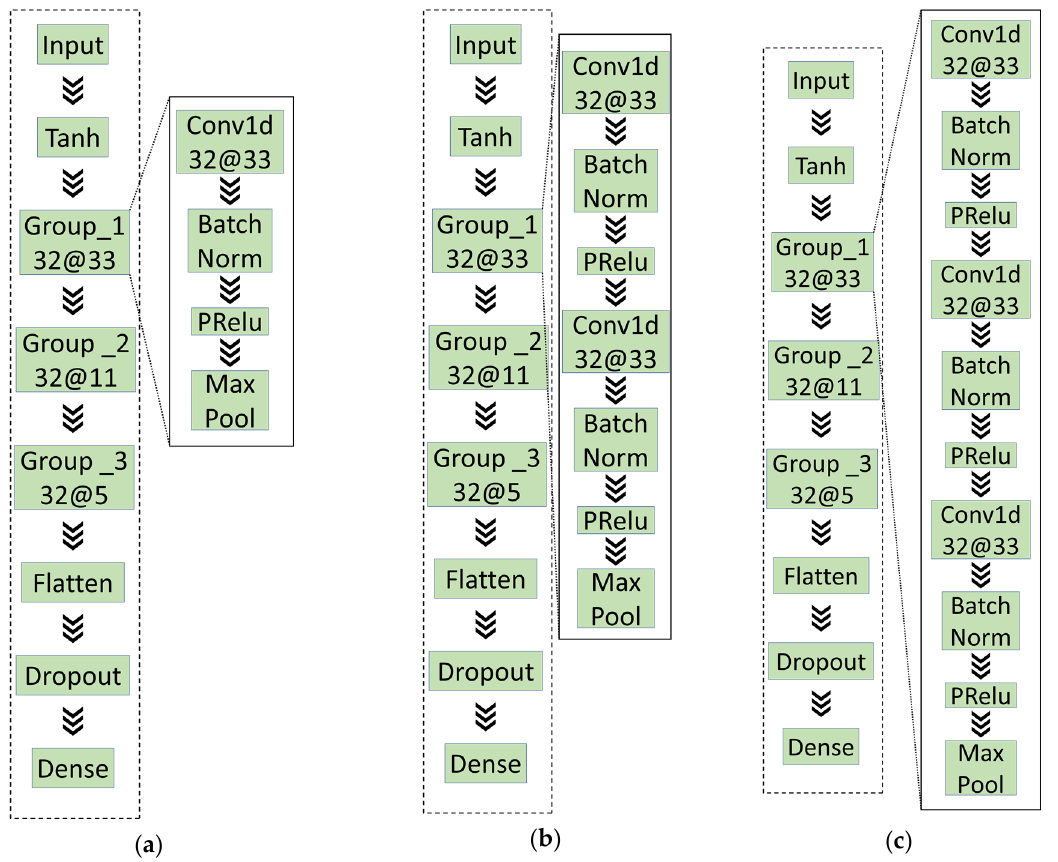
Figure 6. The basic structure of the models in experiment 2: ( a ) A convolutional layer in each convolutional; ( b ) two convolutional layers in each convolutional; ( c ) three convolutional layers in each convolutional.